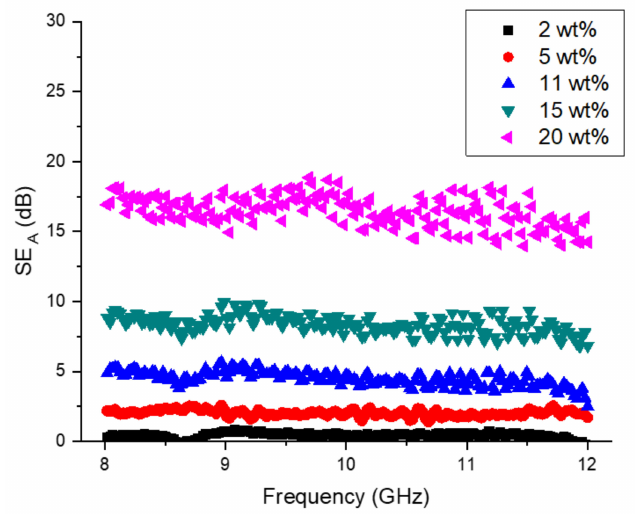
Figure 6. Shielding efficiency due to absorption for CH/Na/CuSe polymer matrix with 2 wt% to 20 wt% of CuSe